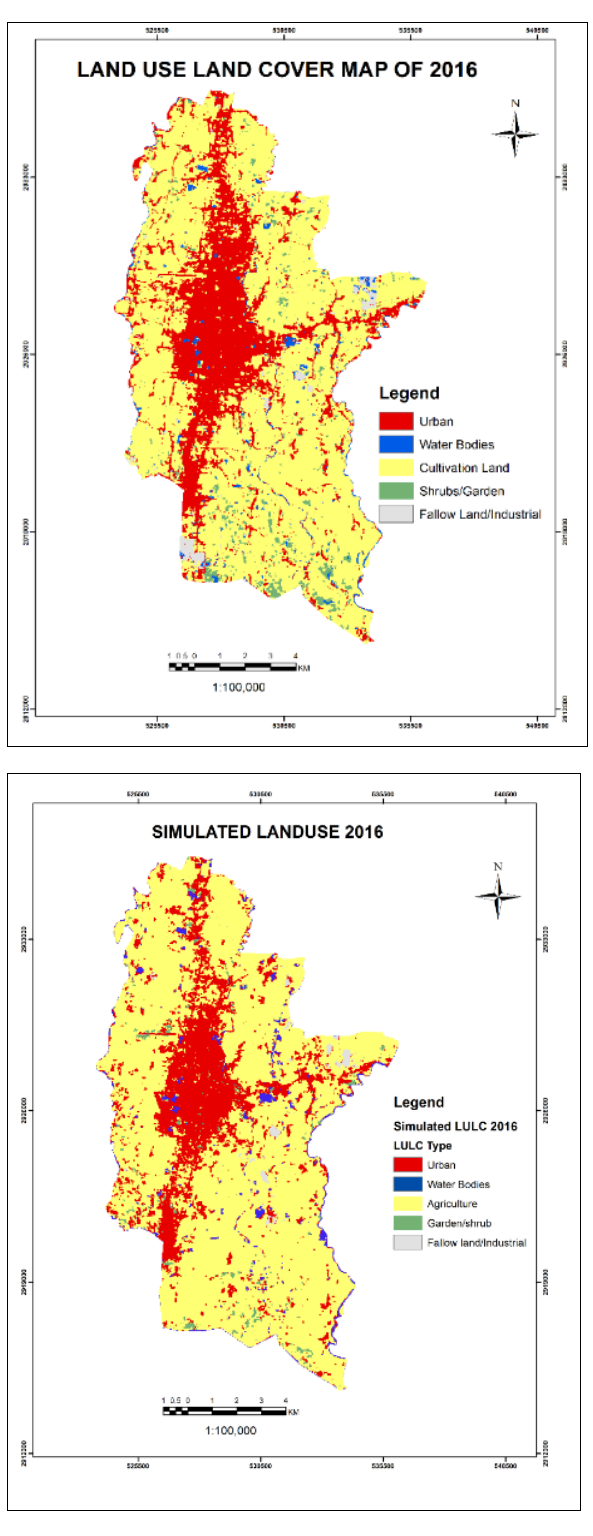
Figure 2. Actual and simulated land use land cover map of 2016